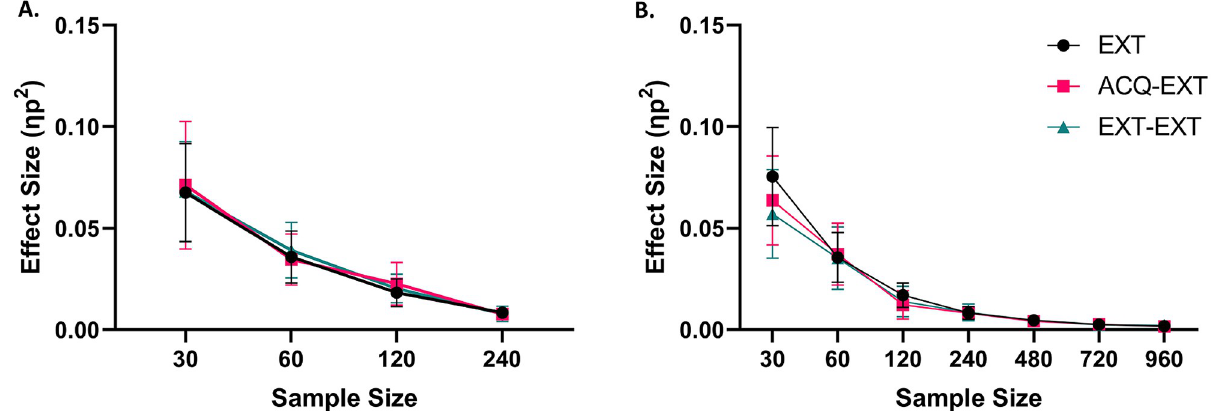
Fig 3. Average effect size decreased as sample size increased for all types of analyses ( p < .001). Panel A is the correlation using resampled data of responses. Panel B is the correlation using resampled data of responses. Error bars are 95% Confidence Intervals.